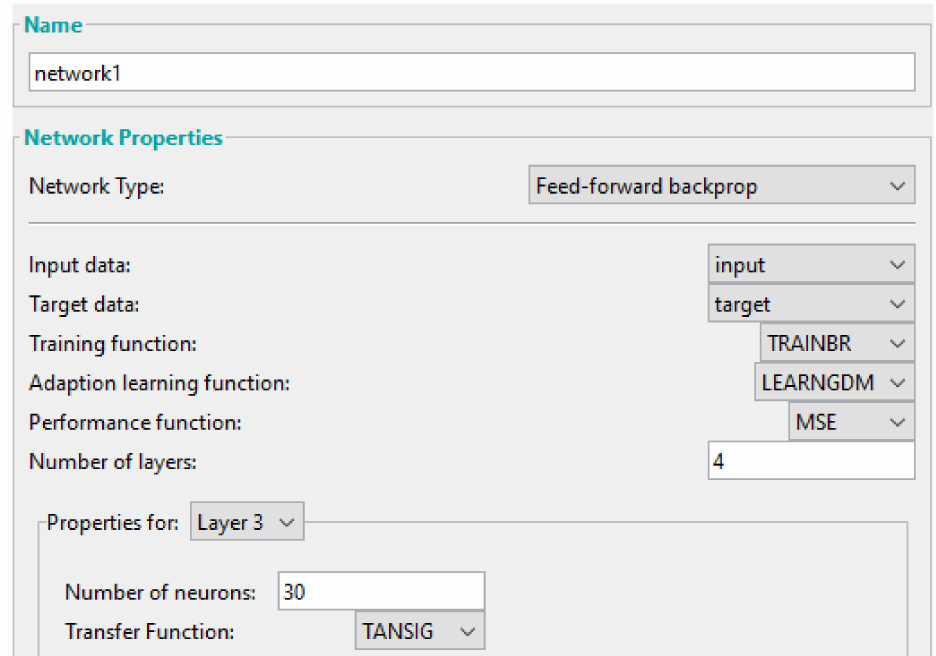
Figure 5. The setup for the training of network